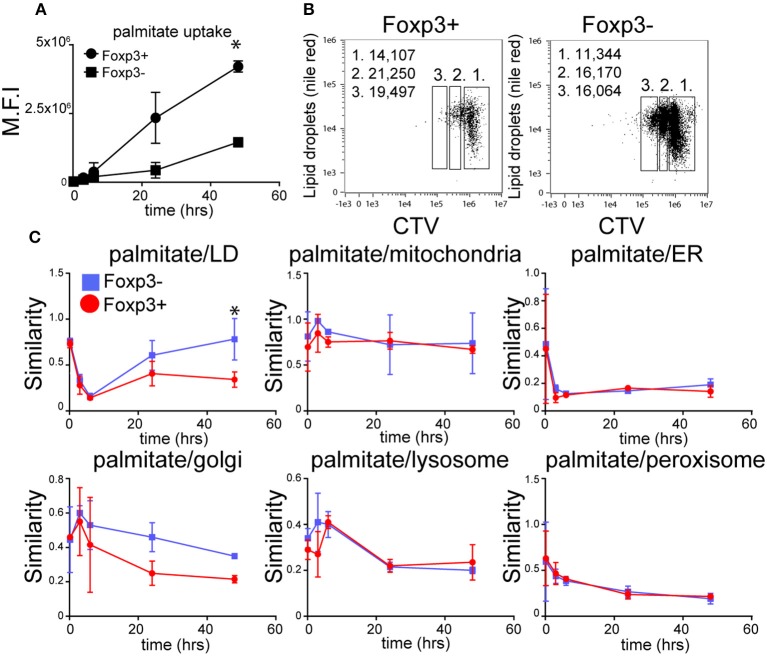
The dynamics of fatty acid uptake and localization differs between Foxp3+ T cells and Tconv. (A) Accumulation of BODIPY-labeled palmitate by Foxp3+ T cells and Tconv in mixed CD4 T cell cultures from B6KI mice activated with anti-CD3/CD28 beads for 48 h measured using imaging cytometry. Error bars represent standard error of the mean, *p < 0.05. Representative of three separate experiments. (B) Comparison of LD content measured by nile red staining in CD4+ T cells from B6KI mice activated with CD3/CD28 beads for 48 h, stained for Foxp3 and CTV. Left panel; CD4+ T cells gated on Foxp3+ and right panel, Foxp3− stained with nile red and CTV. Gate 1 = undivided, gate 2 = 1st cell division, gate 3 = 2nd cell division. Numbers in the top left of the plots represent mean number of lipid droplets per cell division gate. (C) Tracking of BODIPY-labeled palmitate within subcellular compartments of mixed CD4+ T cells from B6KI mice activated for 48 h. BODIPY-palmitate was added at time zero and cells were analyzed by imaging cytometry at 10 min, 3 h, 6 h, 24 h, and 48 h. Cells were stained for Foxp3 and mitotracker to identify mitochondria, nile red for LD, catalase for peroxisomes, CD107 for lysosomes, IP3R1 for endoplasmic reticulum, and Golgin-97 for the Golgi apparatus. Error bars represent standard error of the mean, *p < 0.05. Representative of three separate experiments.